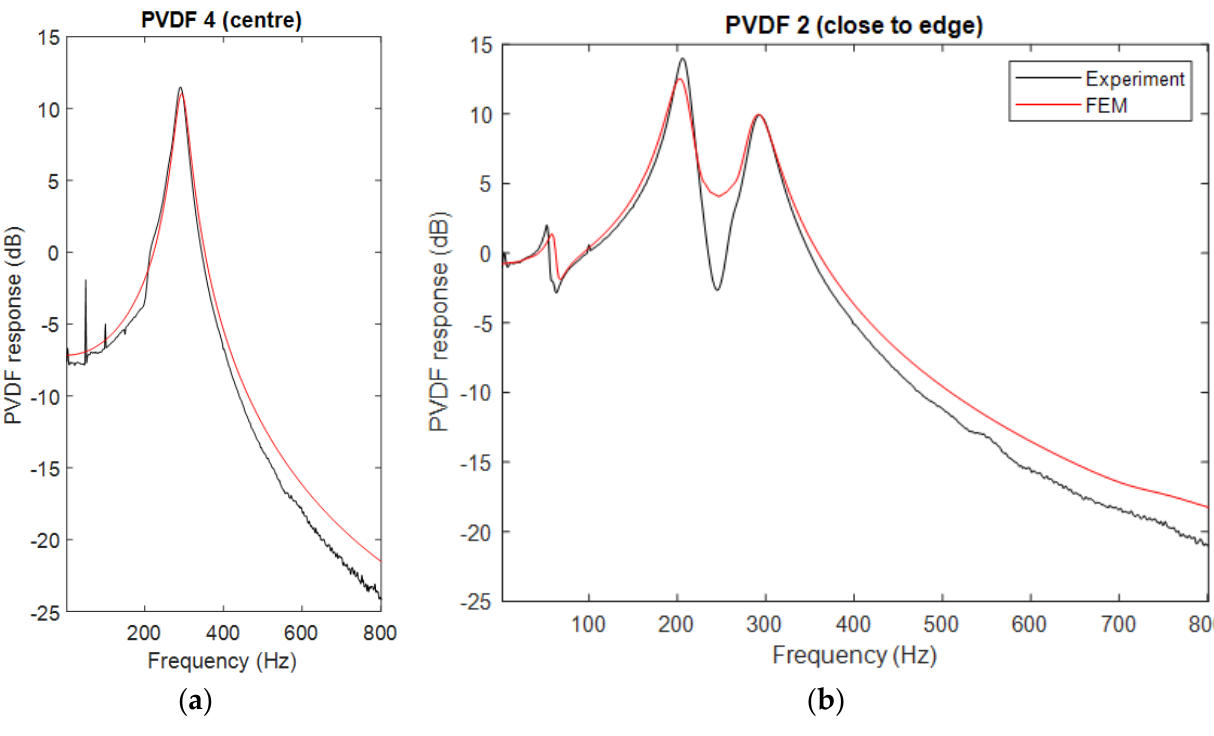
Figure 11. Frequency response of ( a ) PVDF 4 and ( b ) PVDF 2 when the impact is 20 mm away from the center.